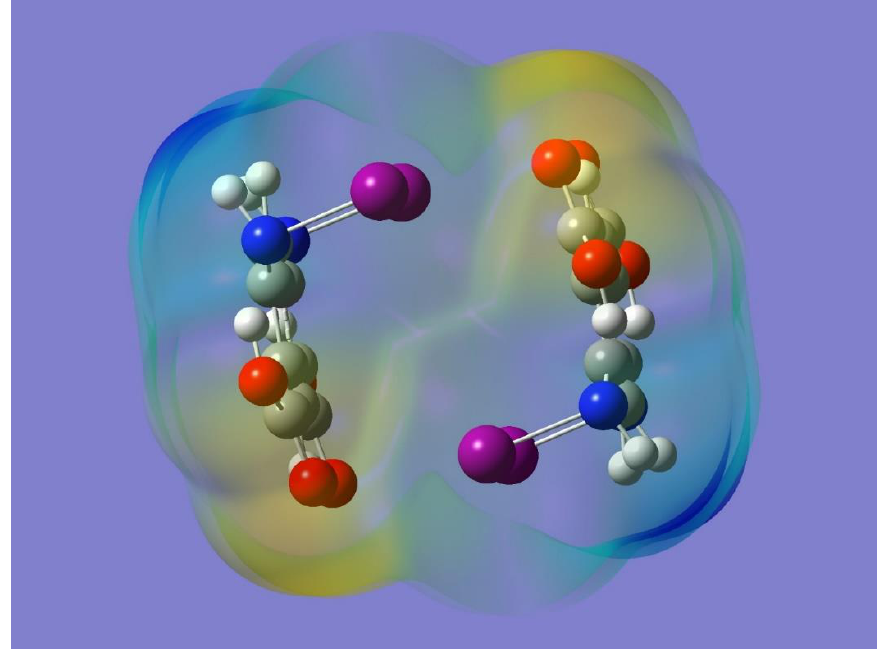
Figure 5. Electrostatic potential on the 0.001-au molecular surface of the optimized dimer system. Yellow-red represents the most negative electrostatic potential and blue the most positive.